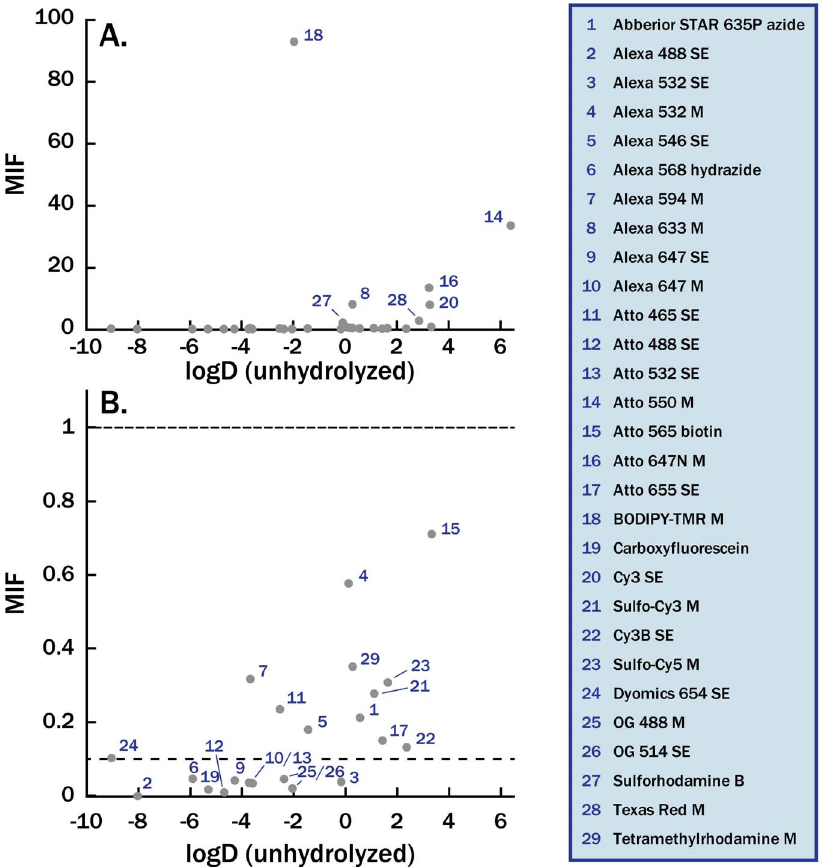
Figure 3. Correlation of MIF values with calculated log D. Calculated log D values are given in Table 1. (A) The MIF value shows moderate correlation with calculated log D values, based on the unhydrolyzed dye structures. (B) Zoom-in on dyes with MIF values below 1. Dyes with a MIF below the bottom dashed line (MIF , 0.1) show little association with membranes, and dyes above the top dashed line (MIF . 1) show appreciable interaction with lipid bilayers. MIF values shown here are the MIF corr values given in Table 1.